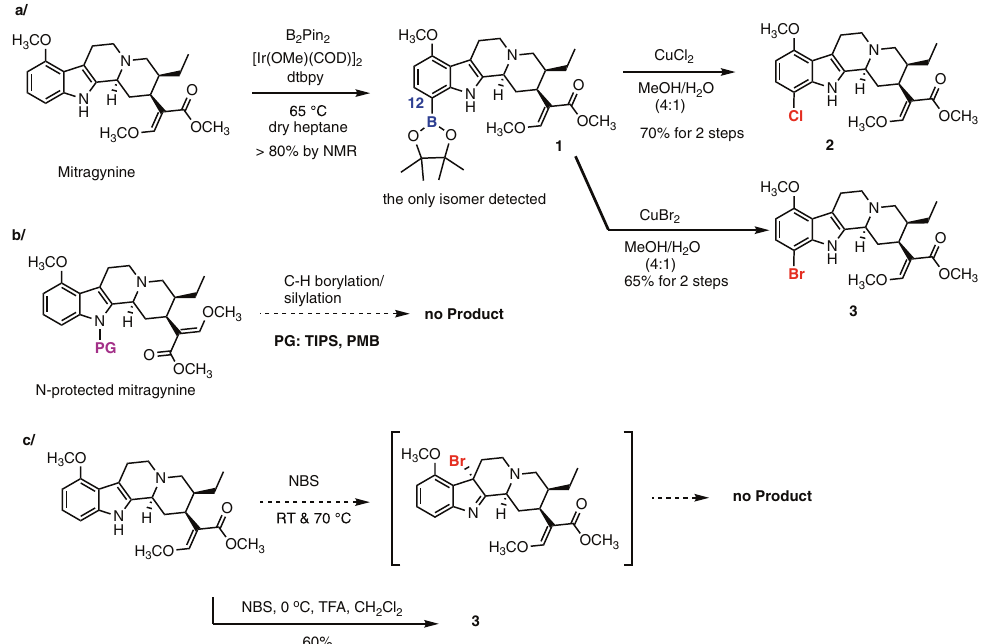
Fig. 2 Examination of direct functionalization of mitragynine indole nucleus. a C – H borylation of MG provides exclusively C12-derivatives consistent with indole directing effects (C7 in indole numbering). The yields are a general range based on >10 repetitions by two experimenters. b The positional selectivity cannot be re-routed to C11 functionalization via previously reported TIPS protection of the indole nitrogen. c The C3-indole halogenation – rearrangement process 53 is not applicable to MG. Bromination under acidic conditions gave 12-Br-MG as the major product.